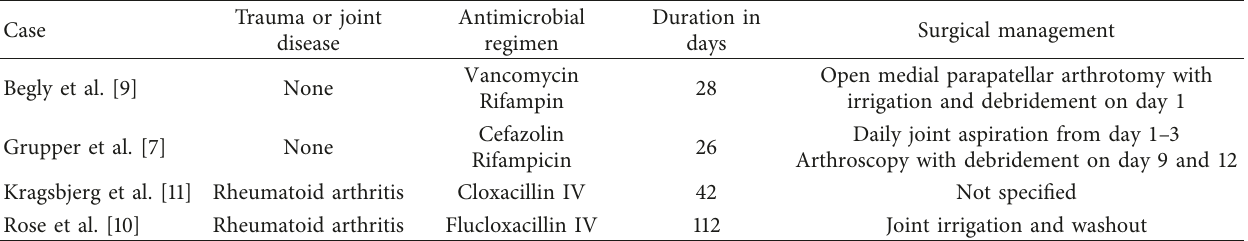
Figure 1: MRI of the knee in (a) T2 sagittal view and (b) T1 coronal view. Table 1: Management of S. lugdunensis